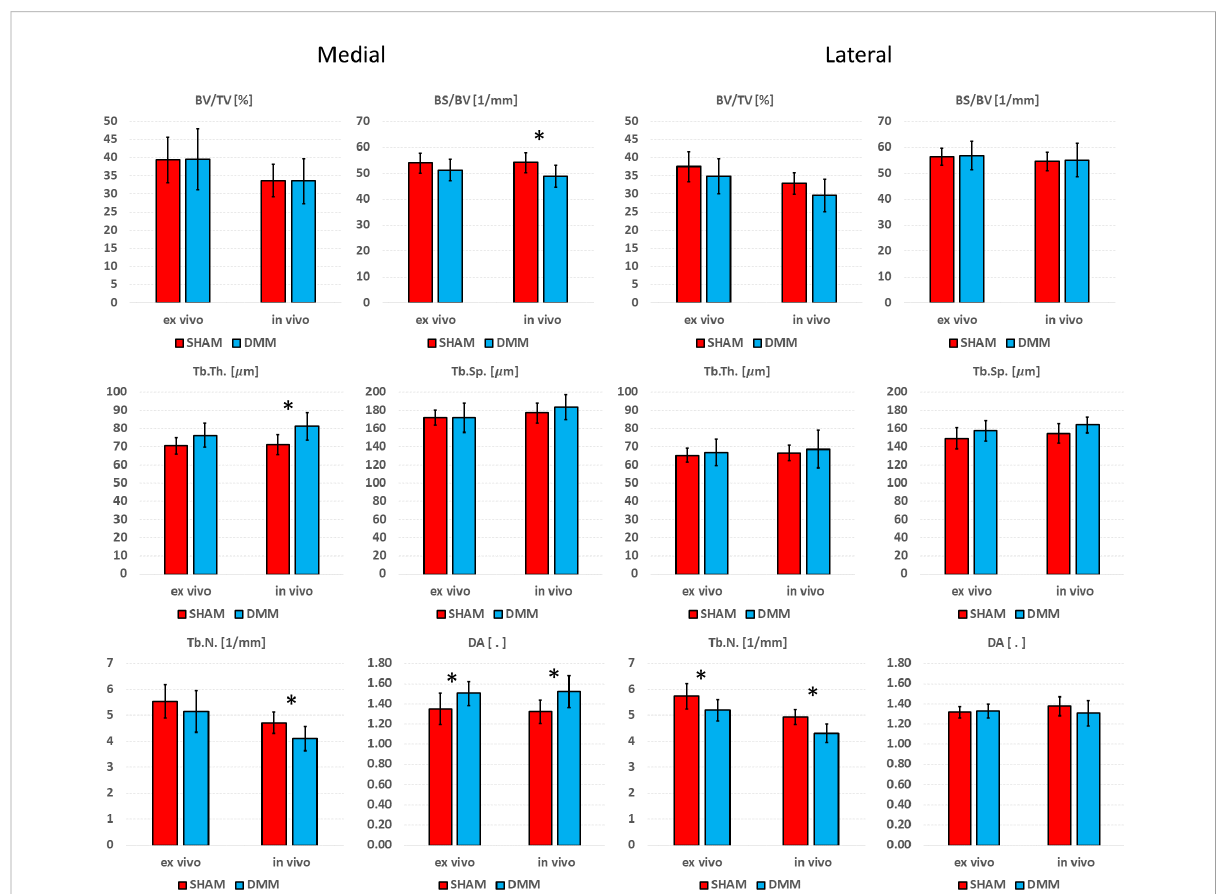
FIGURE 8 Effect of DMM surgery measured with in in vivo and ex vivo microCT in the medial and lateral trabecular compartments. Trabecular bone volume fraction (BV/TV), bone surface fraction (BS/BV), trabecular thickness (Tb.Th), trabecular separation (Tb.Sp), trabecular number (Tb.N), degree of anisotropy (DA). *signi fi cant differences